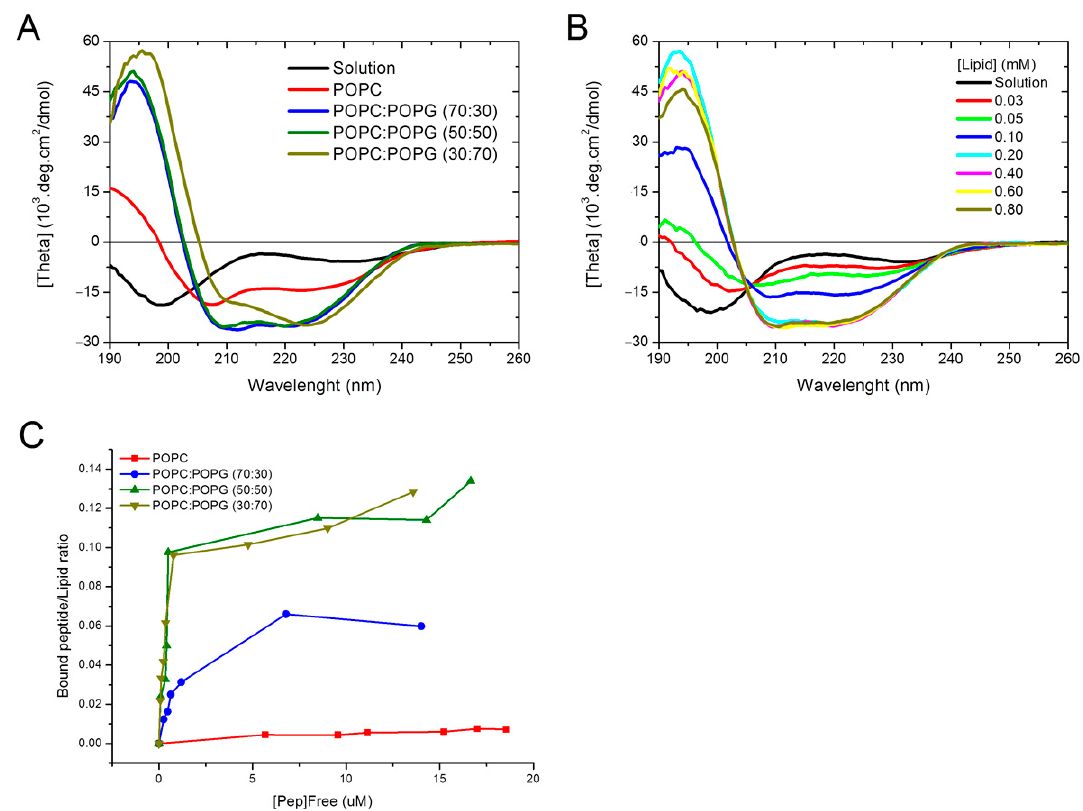
Figure 4. ( A ) CD spectra of NAPHT-BP100 in solution and in the presence of 0.6 mM of LUVs composed of POPC and POPG at different proportions, in 10 mM Tris-HCl buffer, pH 7.4. ( B ) CD spectra of NAPHT-BP100 in solution with different concentrations of POPC:POPG (50:50, molar ratio) in 10 mM Tris-HCl buffer, pH 7.4. ( C ) Binding isotherms of NAPHT-BP100 to LUV in 10 mM Tris-HCl buffer, pH 7.4. The peptide concentration was 20 µ M and temperature 25 °C.